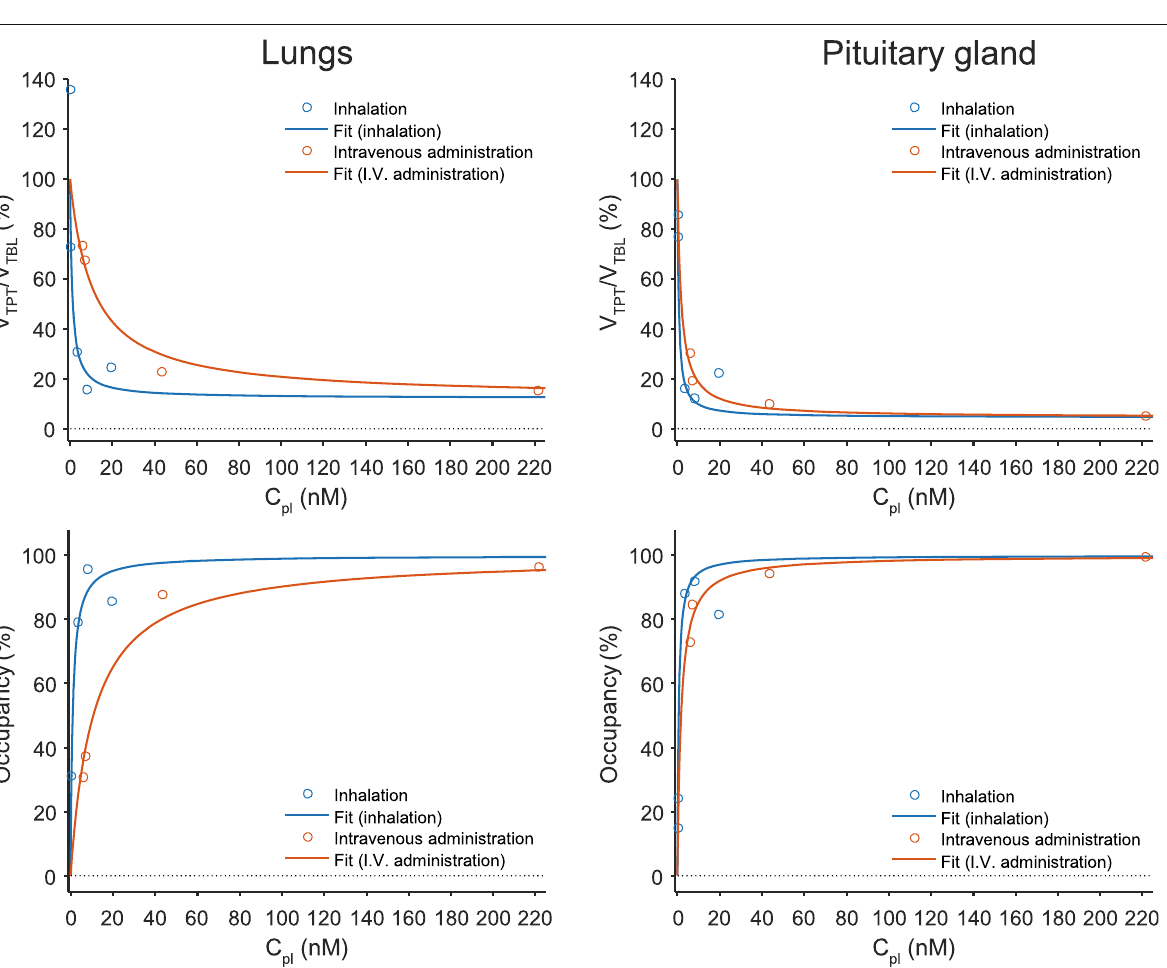
Fig. 5 The relationship between plasma ipratropium concentration and changes in organ-specific binding of [ 11 C]VC-002. Upper panels show changes in total binding (estimated using post-dosing over baseline V T ratios) for the lungs and the pituitary gland, respectively. Lower charts show estimated changes in specific binding (i.e., target occupancy) for the two organs, respectively. The charts indicate subject- and occasion-specific data as scatter points and the results of model fitting as continuous curves. In detail, the scatter points for total binding were used to fit a model